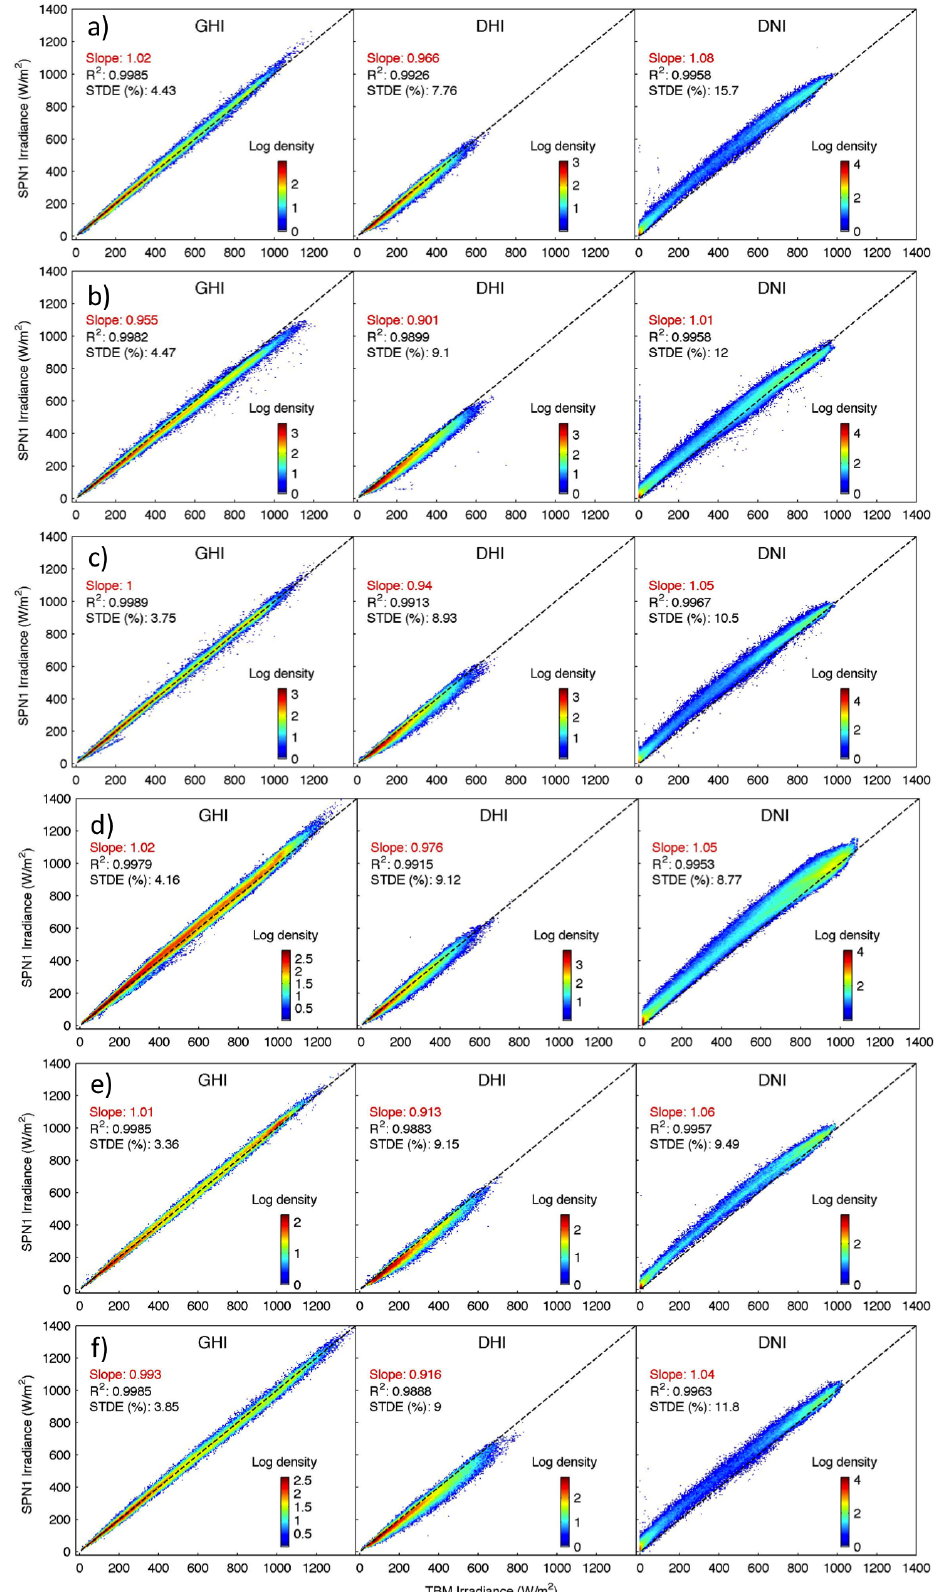
Figure 2. SPN1 vs. TBM measurements for GHI, DHI and DNI at (a) Winster, (b) Palaiseau, (c) Payerne, (d) Golden, (e) Addu Atoll and (f)